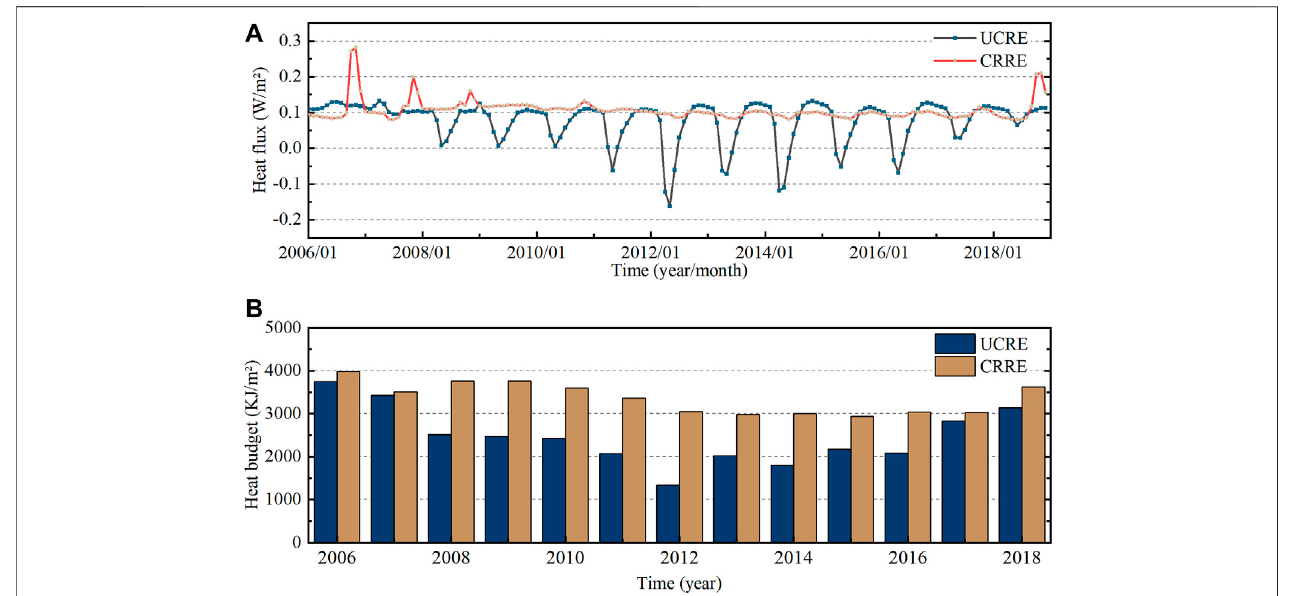
FIGURE 10 | Heat fl ux (A) and heat budget (B) of soil layers between depths of 5.0 and 5.5 m of the UCRE and CRRE.